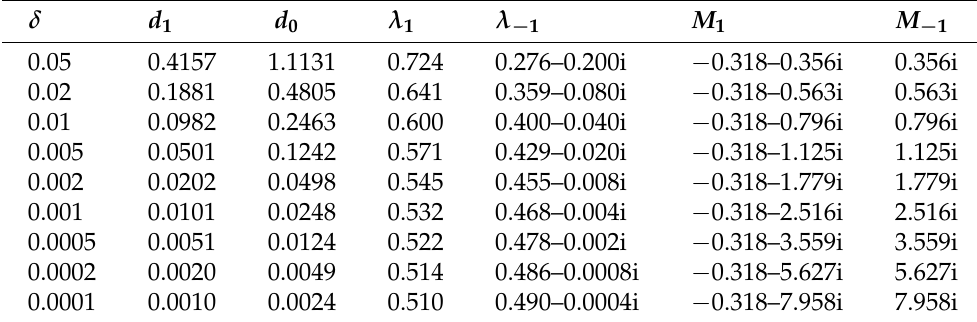
Table 1. Numerical